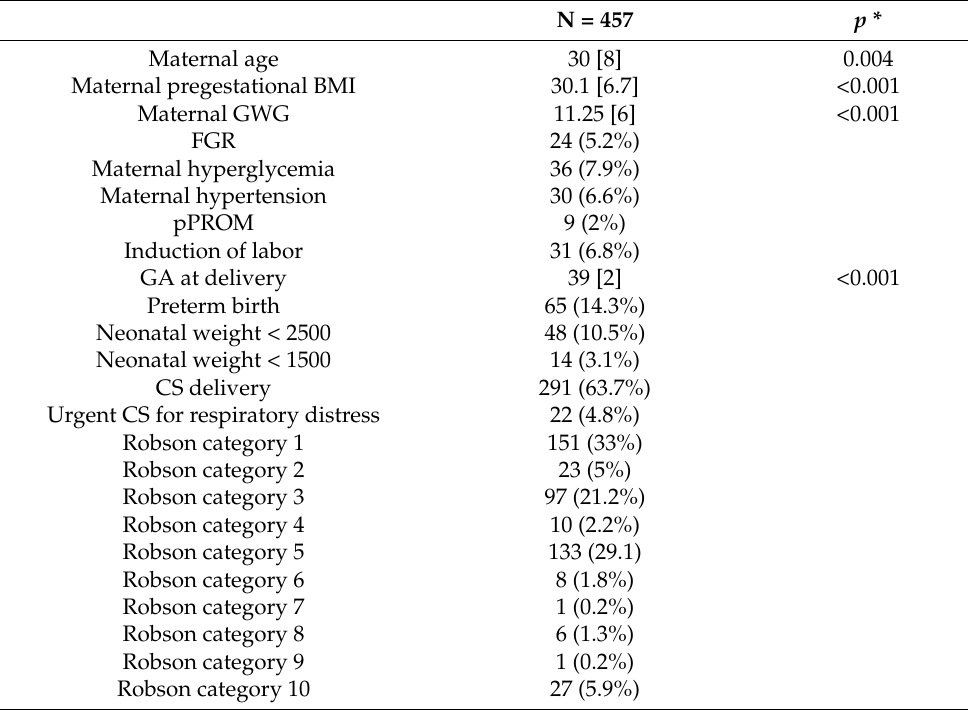
Table 2. Pregnancy characteristics of included patients. Data presented as n (%) or median [interquar- tile